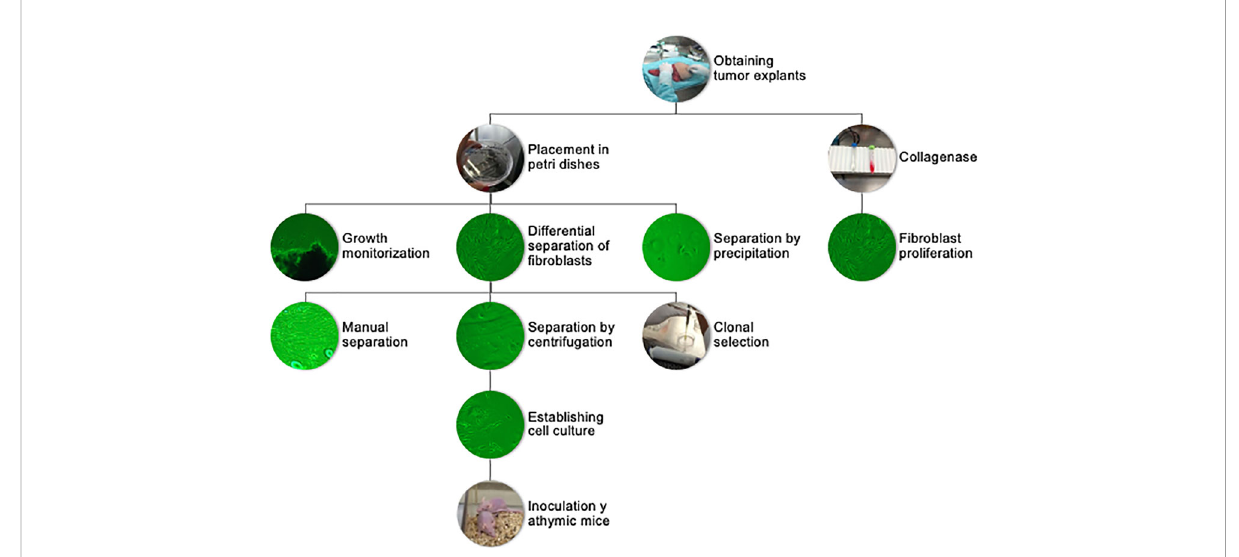
FIGURE 1 Flowchart of sample processing, from tumor explant to primary cultures and tumorigenic